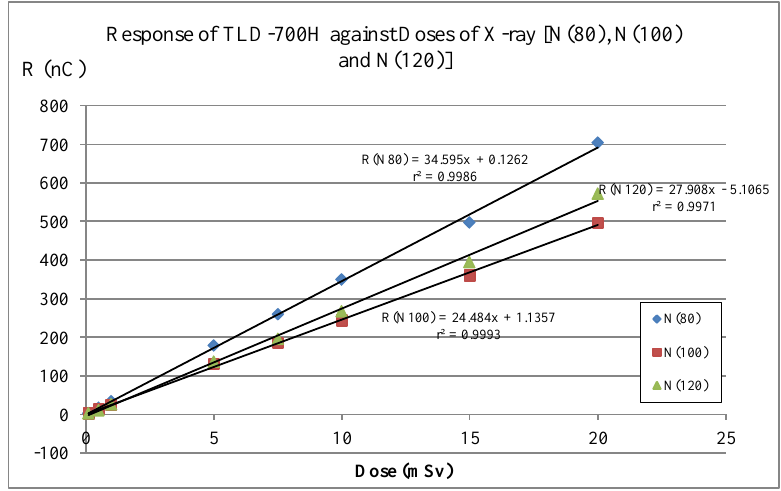
Figure 8. Response of TLD-700H against doses of X-ray [N (80), N (100) and N (120)]